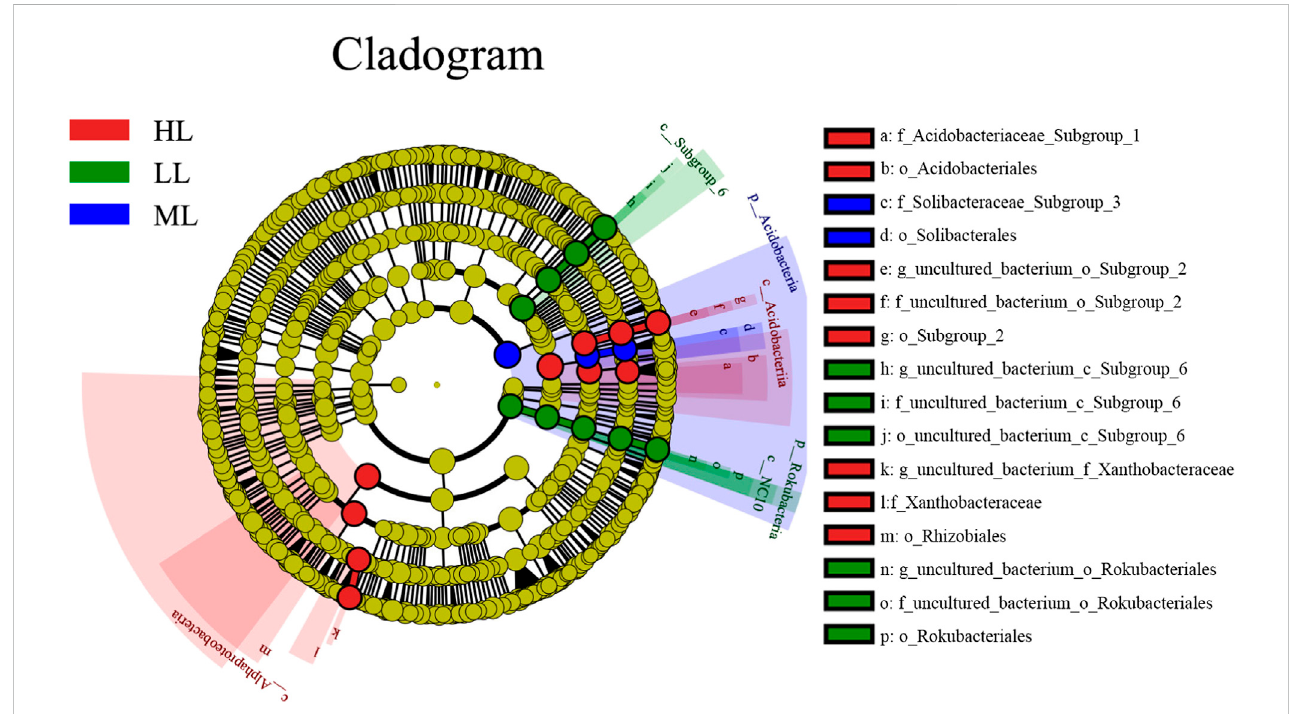
Cladogram of the bacterial communities at the three latitude soils with LDA > 4.5 (A). LL, low-latitude; ML, mid-latitude; HL, high-latitude.